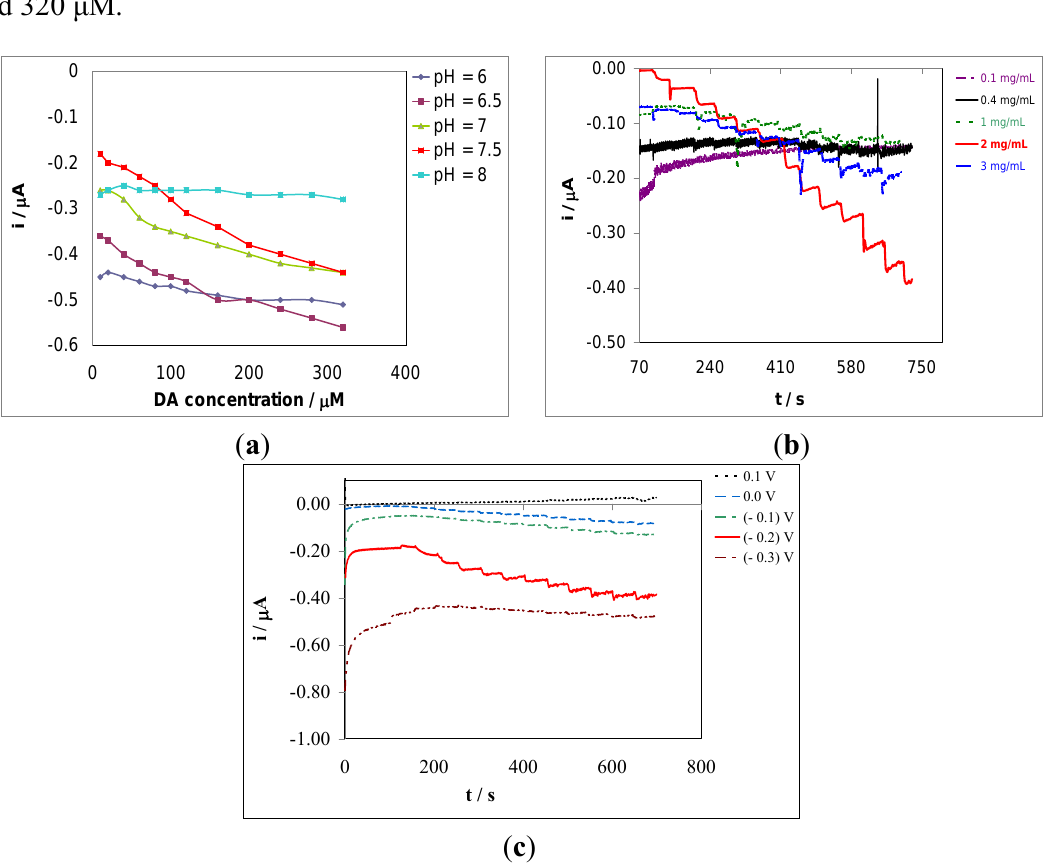
Figure 4. (a) Influence of the pH of solution on the gold disk electrode based biosensor response in aqueous solution containing a 0.1 M phosphate buffer and DA concentrations of 10, 20, 40, 60, 80, 100, 120, 160, 200, 240, 280, and 320 μ M. Detection potential: − 0.20 V vs. Ag/AgCl; ( b ) Influence of the enzyme concentration in the deposition solution on the gold disk electrode based biosensor response in aqueous solution containing a 0.1 M phosphate buffer of pH 7.5 and DA concentrations of 10, 20, 40, 60, 80, 100, 120, 160, 200, 240, 280, and 320 μ M. Detection potential: − 0.20 V vs. Ag/AgCl. ( c ) Influence of the detection potential in continuous amperometric mode under stirring conditions, on the gold disk electrode based biosensor response in aqueous solution containing a 0.1 M phosphate buffer of pH 7.5 and DA concentrations of 10, 20, 40, 60, 80, 100, 120, 160, 200, 240, 280, and 320 μ